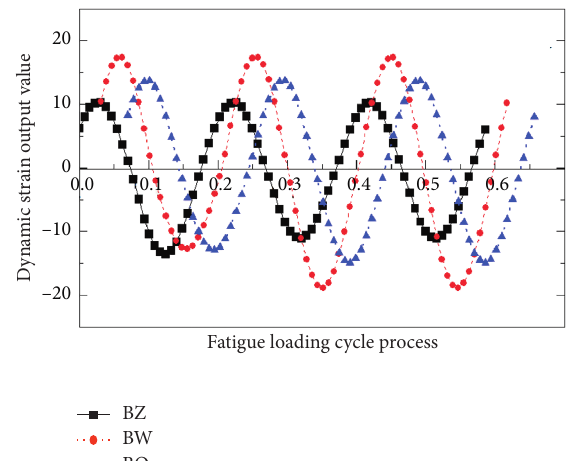
Figure 13: Development of static strain under fatigue